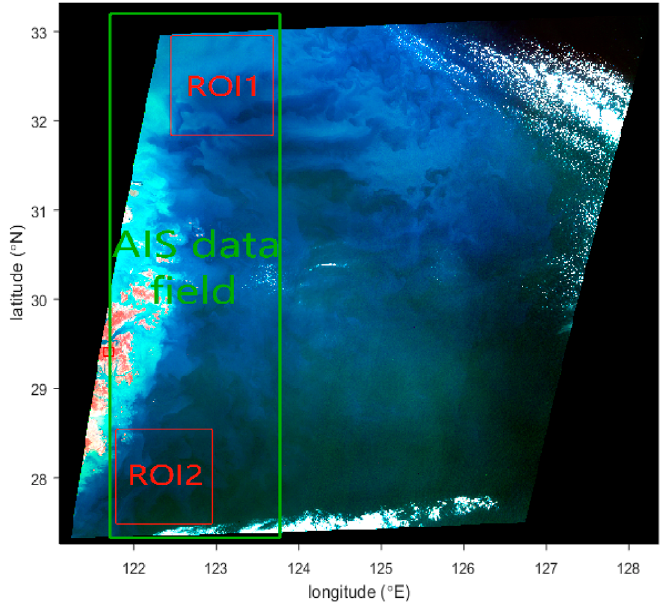
Figure 7. Research area and dataset